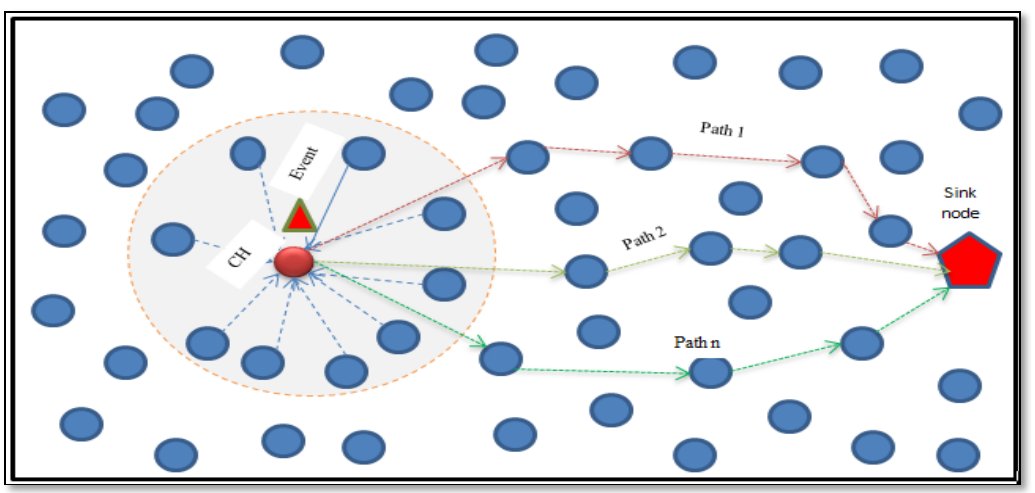
Figure 3. E ffi cient multipath routing based on genetic algorithm Figure 3. Efficient multipath routing based on genetic algorithm (EMRGA).